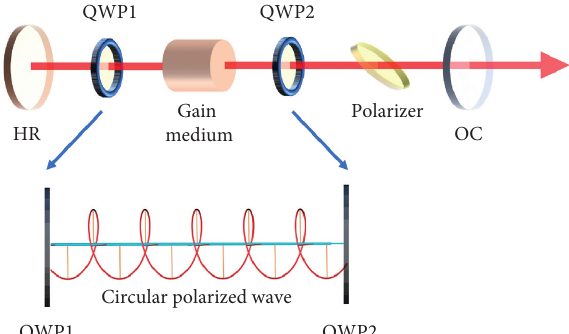
Figure 8: Schematic showing the principle of the twisted mode